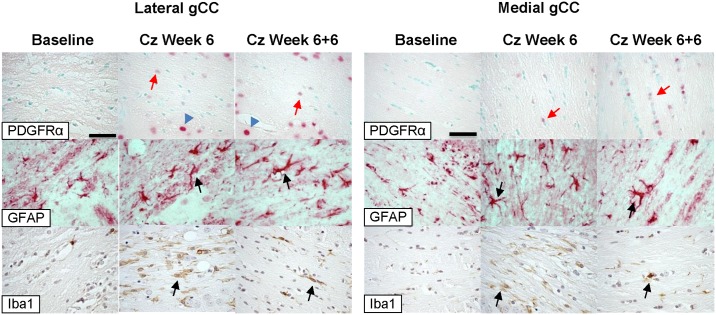
Immunohistochemical analyses of gCC.OPCs stained with PDFRα appear red (red arrows), often in a tight line with other cells, in the top row (25μm scale bar applies to all images). Note that neurons (blue arrowheads) expressing PDGFRα exhibit large, round nuclei. Activated astrocytes, stained red, are identified by an enlarged cell body and stalky processes in the second row (arrows). Microglia appear brown in the bottom row (arrows).